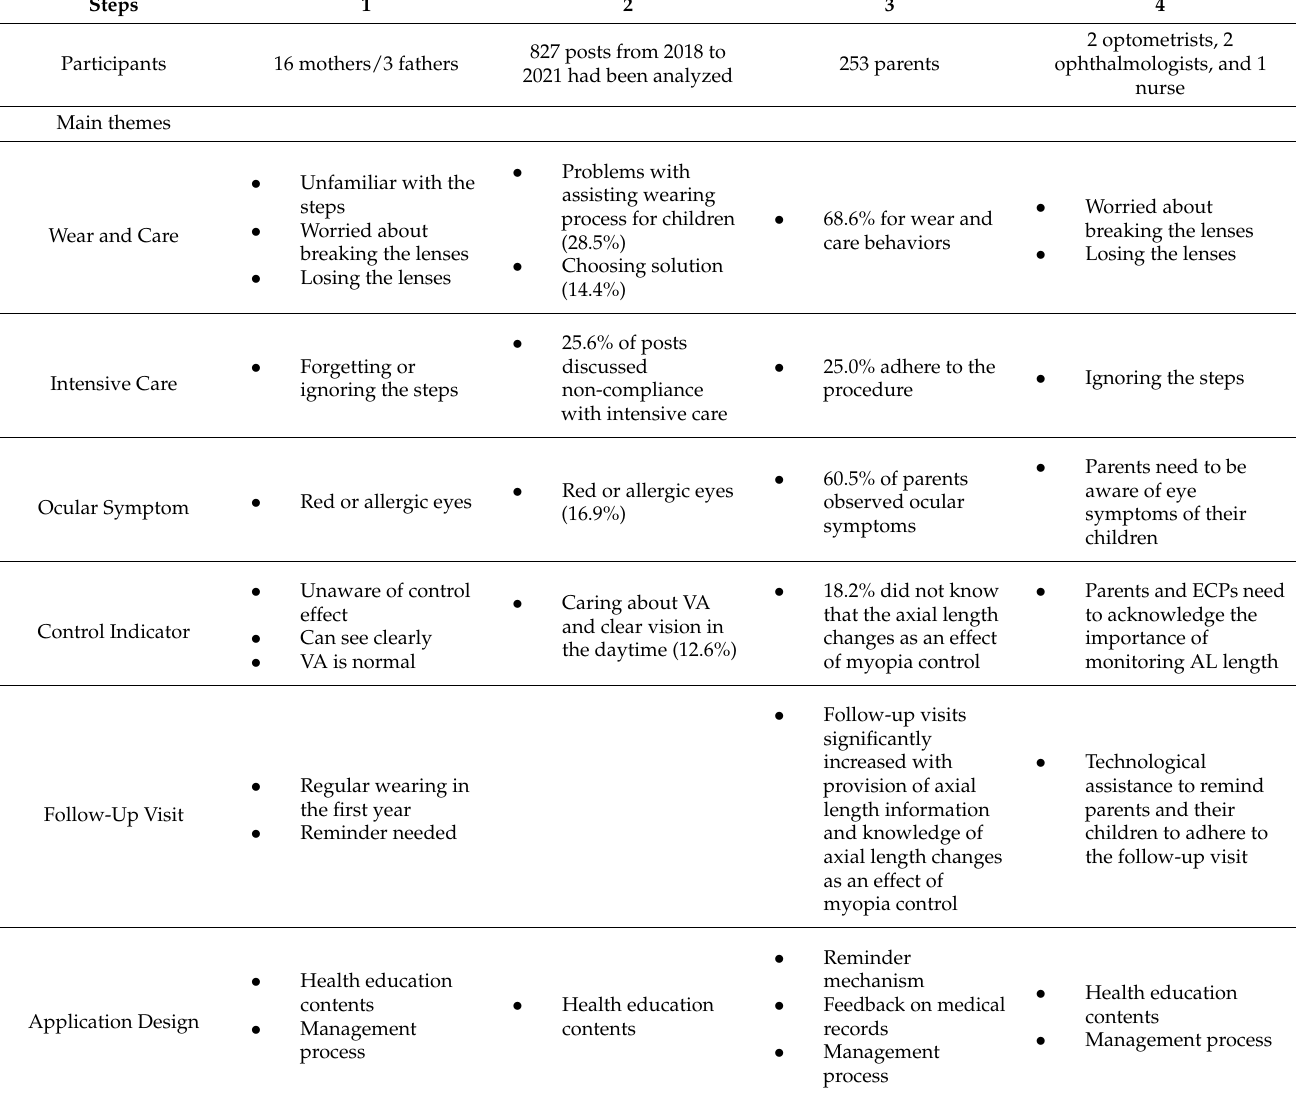
Table 2. Needs assessment results and app